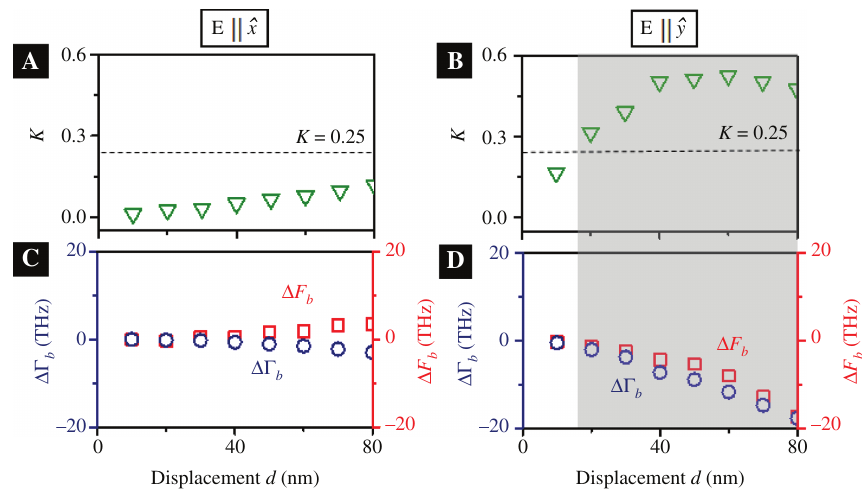
Figure 6: Analyses on two CMT parameters related to the validity of Fano’s formula. The effective far-field inter-mode interaction K (A, B), changes of the radiation loss ΔΓ calculated with the retrieved CMT as shown in Figure 5, for samples with different values of d and under excitations of normally incident lights with different polarizations. The shaded area denotes the region where Eq. (1) is no longer